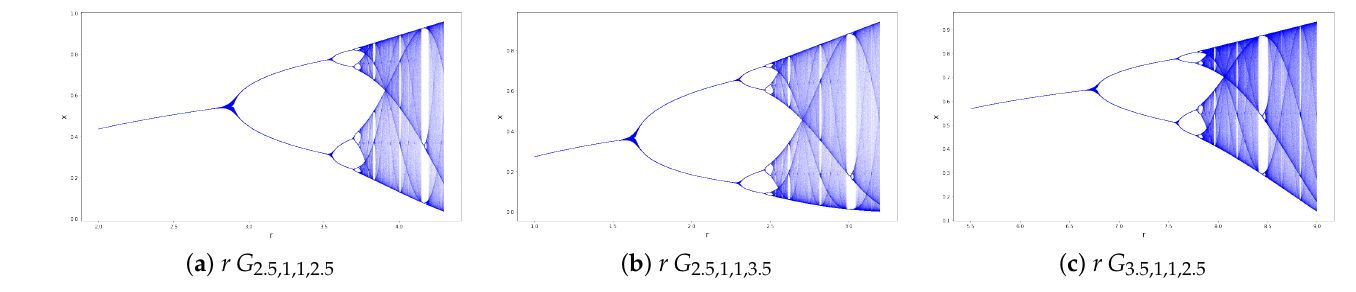
Figure 11. Hyper-Gompertz bifurcation